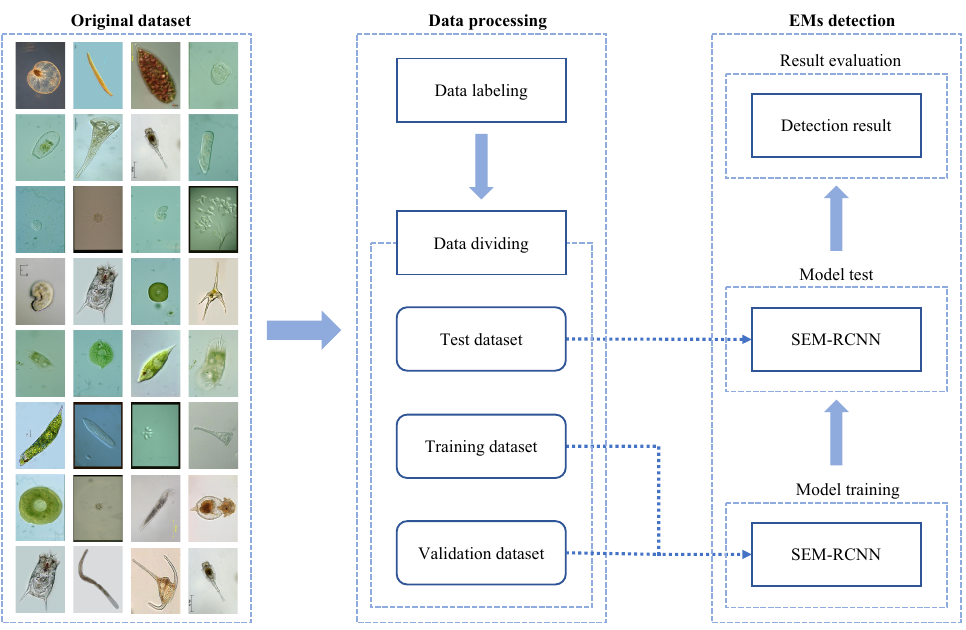
Figure 1. The flowchart of